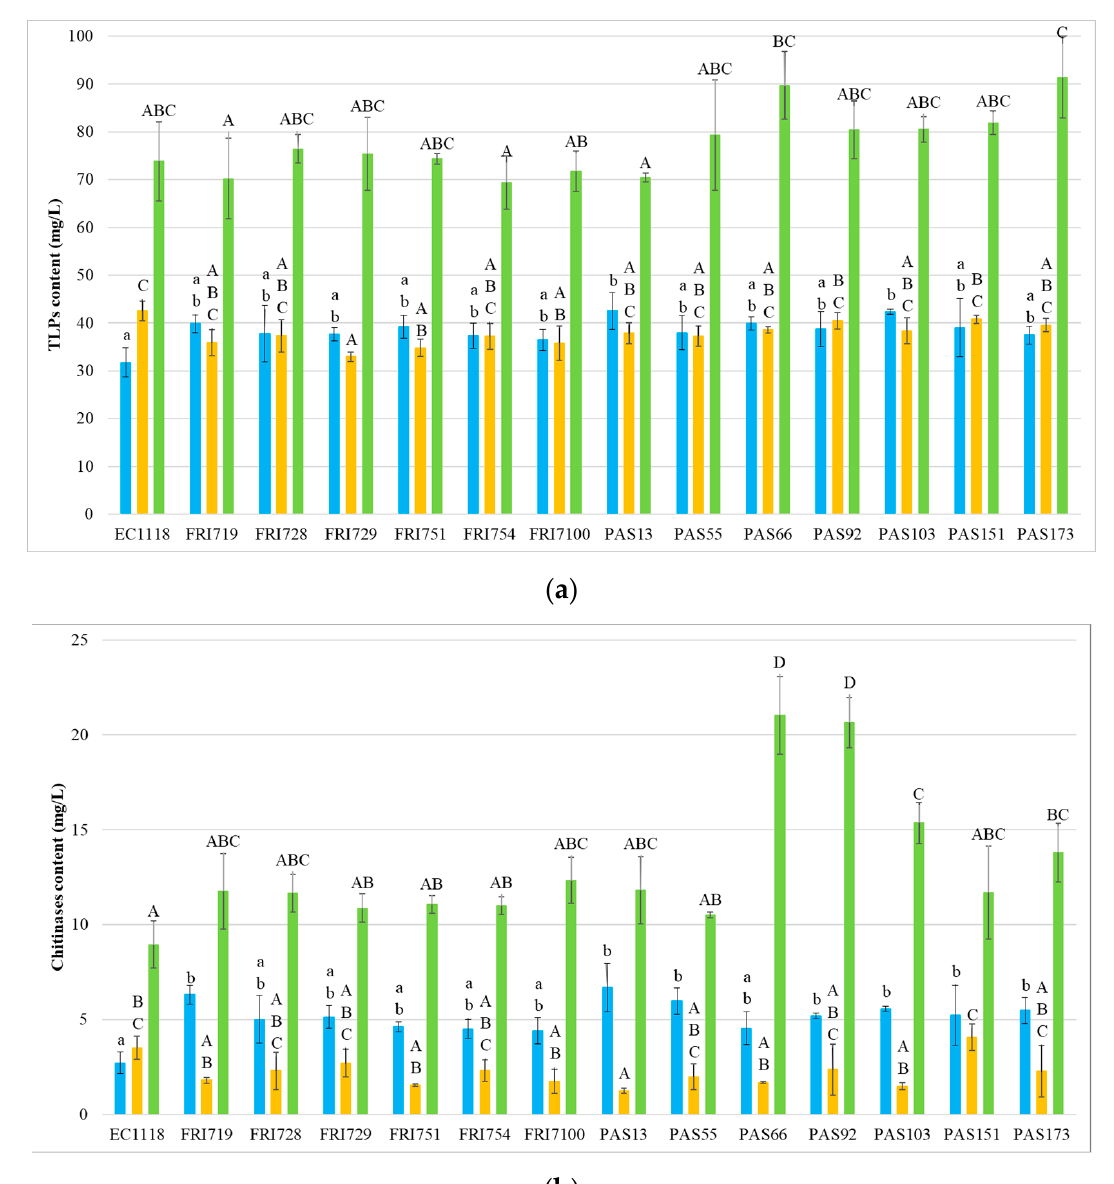
Figure 2. Concentration (as mg/L thaumatin) of PR proteins in the 42 experimental wines. ( a ) Concentration of TLPs. ( b ) Concentration of chitinases. ■ Sauvignon blanc ■ Pinot grigio ■ Manzoni bianco. Values are represented by the average (bars) and standard deviation (error bar) ( n = 3). The difference between the averages was analyzed by one-way ANOVA and Tukey post hoc tests. Different letters indicate significant statistical differences p < 0.05 (Tukey’s test) among the fermentation trials.